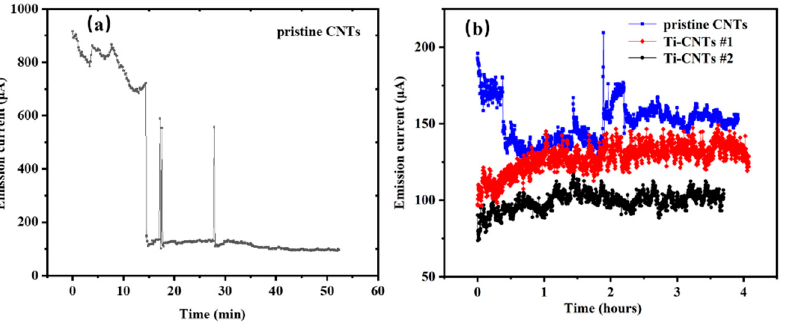
Figure 7. Emission current summary of Ti-coated CNTs and pristine CNTs over time. ( a ) Aging conditioning of pristine CNTs during a short period. ( b ) Stability comparison.